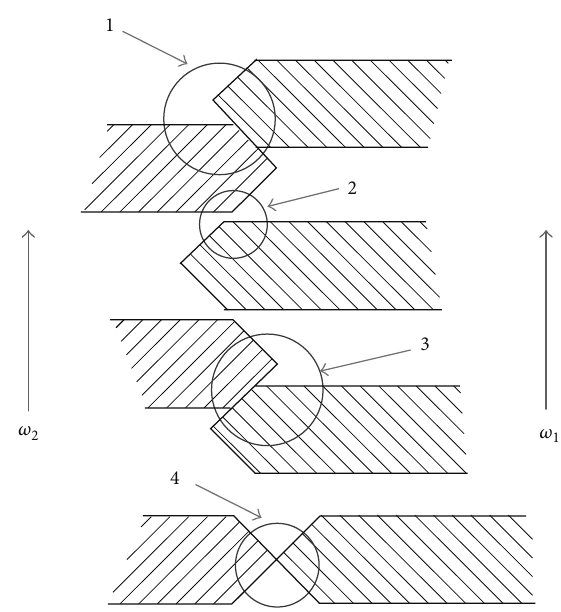
Figure 6: Position relationships between the teeth of shift sleeve and those of shift